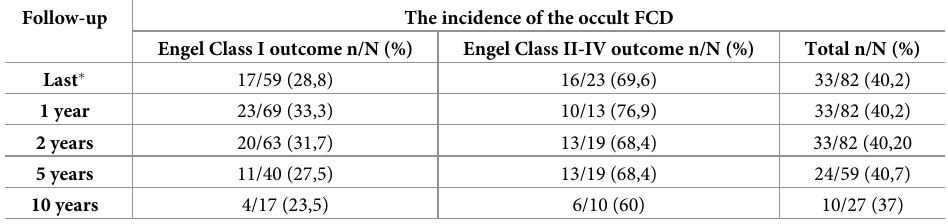
Table 2. The influence of occurrence of the occult FCD on epilepsy surgery outcomes in subsequent years of post- operative follow-up. Follow-up The incidence of the occult FCD Engel Class I outcome n/N (%) Engel Class II-IV outcome n/N (%) Last